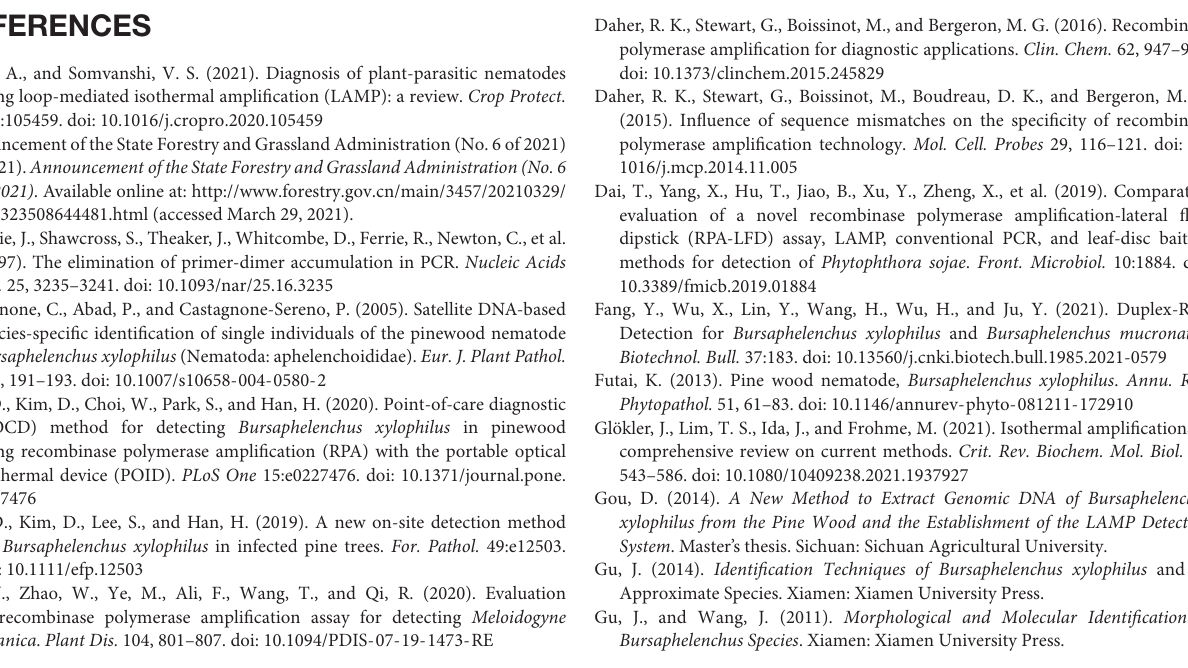
Supplementary Figure 1 | Nucleotide sequence alignment of the syg-2 gene part sequence from Bursaphelenchus xylophilus (Bx), Bursaphelenchus mucronatus (Bm), and Bursaphelenchus doui (Bd). Location of S1F/R primers and S1-nfo-P are marked by black arrow lines, respectively. Gaps in sequence alignment were indicated by